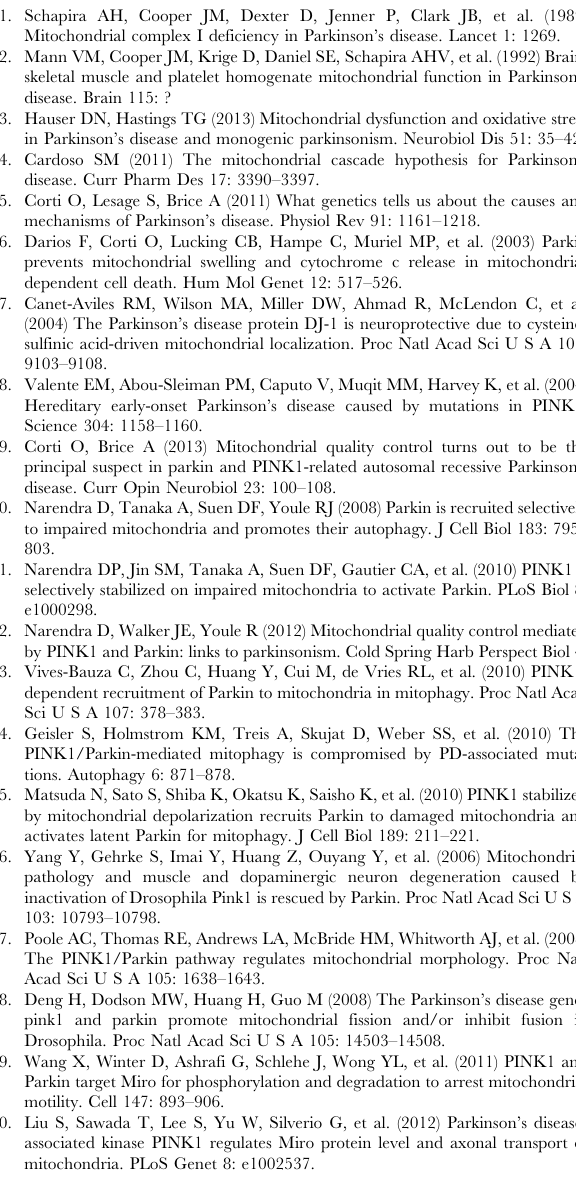
Figure S1 Scheme of the different brain fractionation methods used to assess mitochondrial functions. Figure S2 Respiratory control ratios (RCR) in 24- month-old mice. Respiratory control ratios were calculated as state 3/state 4 respiration rate on glutamate + malate as substrates; results are shown as mean and SD; numbers between brackets indicate the number of independent measurements in individual animals of each genotype ( A ) crude mitochondrial pellets from cortex (n= 8), crude mitochondrial pellets from striatum (n= 6) and purified mitochondrial pelllets from whole brain (n =2); ( B